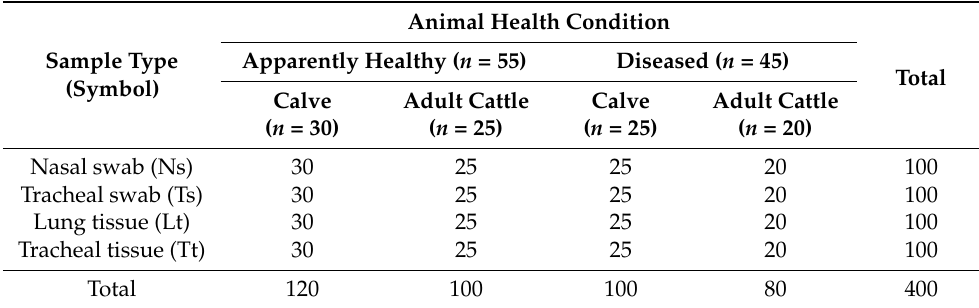
Table 1. Distribution of different samples collected from apparently healthy and diseased cattle in Sharkia Governorate,